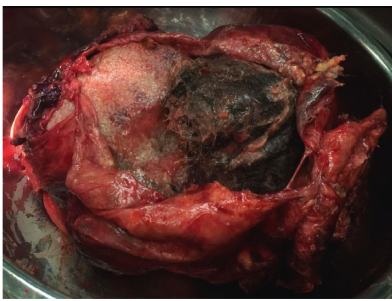
Figure 1: CT scan of the abdomen (coronal view) demonstrating a well-circumscribed cystic mass, with solid components (asterisk), occupying the entire right upper quadrant of the abdomen. The mass measures 19.0 × 19.7 × 13.8cm in its maximal and displaces the right kidney (K) inferiorly and liver (L) anteromedially.